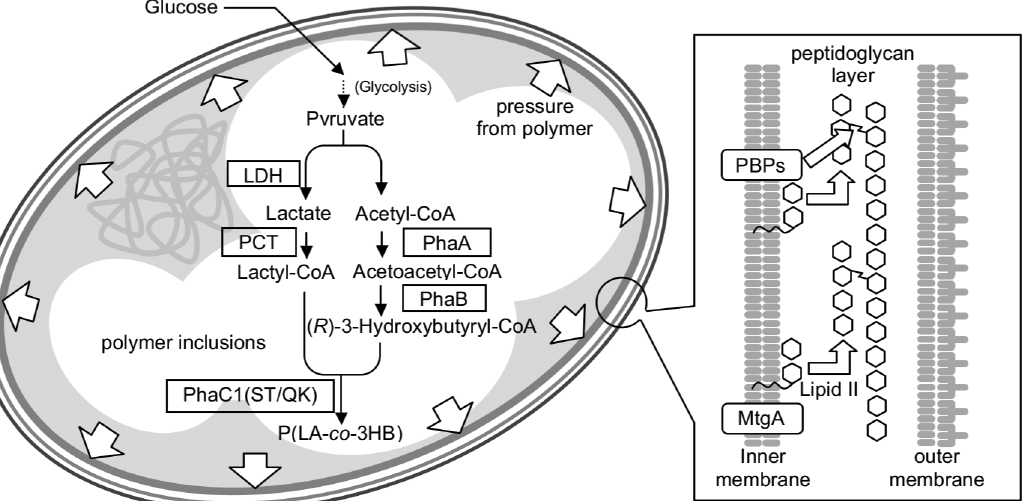
Fig 1. Model of polymer accumulation in fat E . coli cell with mtgA deletion. MtgA is a dispensable monofunctional glycosyltransferase catalyzing the polymerization of lipid II for the extension of glycan strands but not cross-linking. Penicillin-binding proteins (PBPs), which are bifunctional transpeptidases- transglycosylases and monofunctional transpeptidases, play a central role in the peptidoglycan formation. The mtgA deletion had no obvious effect on cell morphology without polymer accumulation, but generated a fat cell phenotype with polymer production. P(LA- co -3HB) production from glucose in E . coli was achieved by expressing four heterologous enzymes; β -ketothiolase (PhaA), acetoacetyl-CoA reductase (PhaB), propionyl-CoA transferase (PCT) and lactate-polymerizing engineered polyhydroxyalkanoate synthase [PhaC1(ST/QK)]. D-Lactate dehydrogenase (LDH) is an intrinsic enzyme. The polymer synthesis may elevate turgor pressure, which expands the cell to form the fat-cell and allowed to accumulate the additional amount of